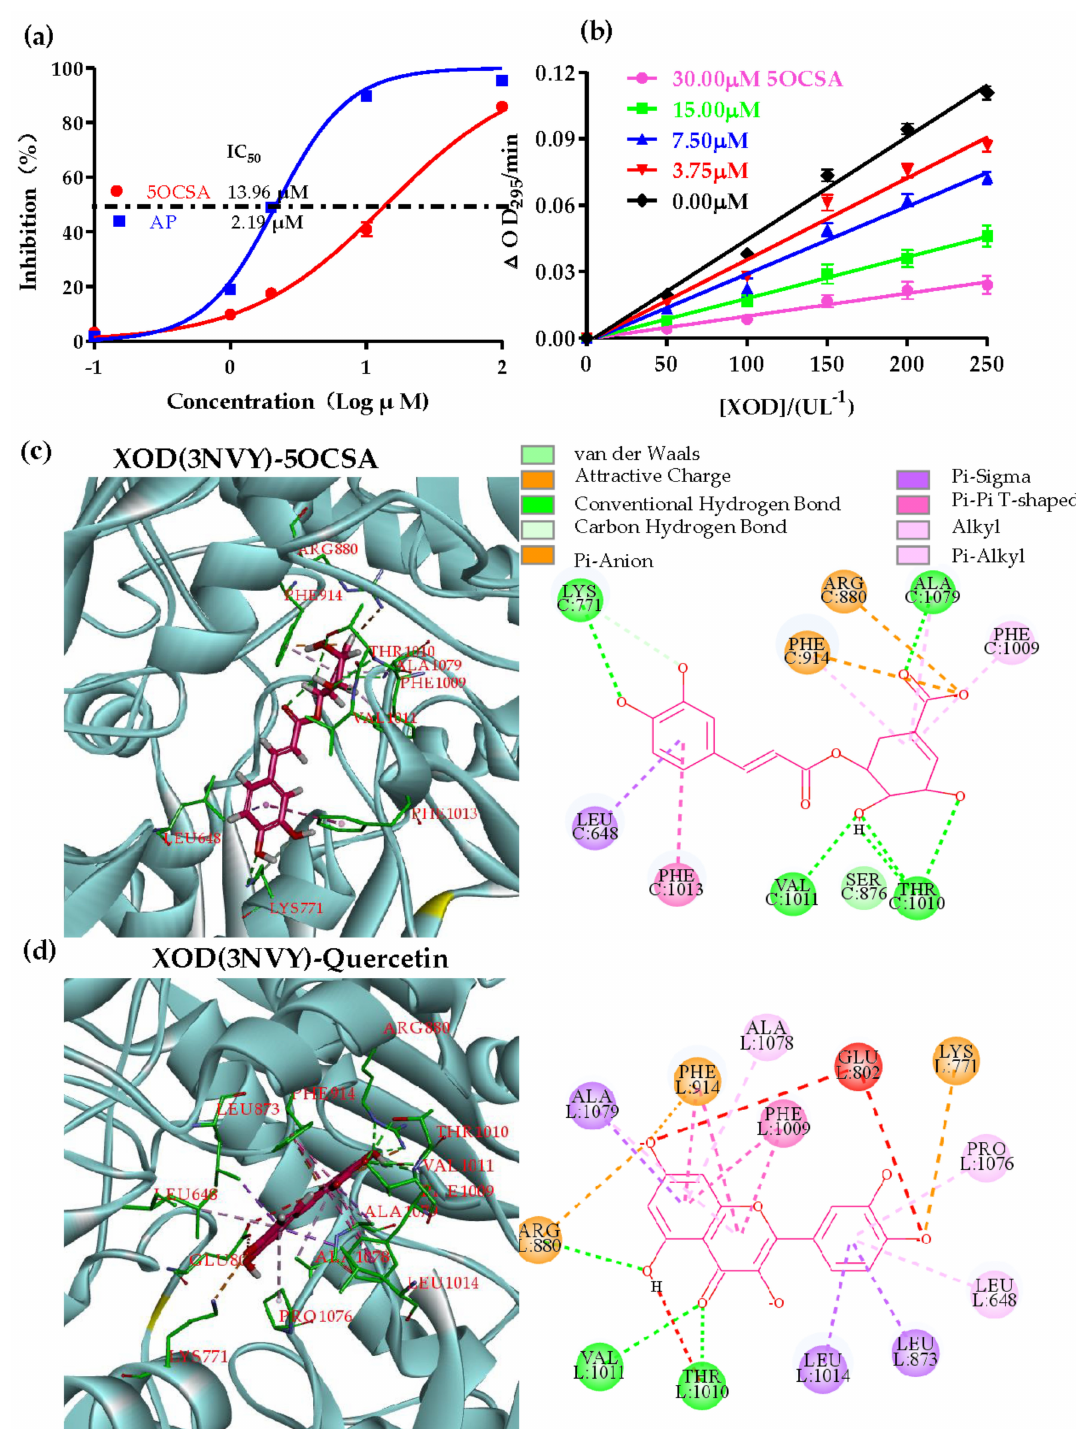
Figure 2. Interaction between 5OCSA and XOD in vitro and in silico. ( a ) IC 50 of 5OCSA and AP on XOD. Plots of v ( ∆ OD 295 /min)/XOD concentration with different concentrations of 5OCSA ( b ). Predicted binding mode of 5OCSA docked into XOD. 3D and 2D docking patterns of 5OCSA ( c ) and quercetin ( d ) into 3NVY has been generated by Discovery Studio 4.5. 5OCSA: 5- O -caffeoylshikimic acid; XOD: xanthine oxidase; AP: